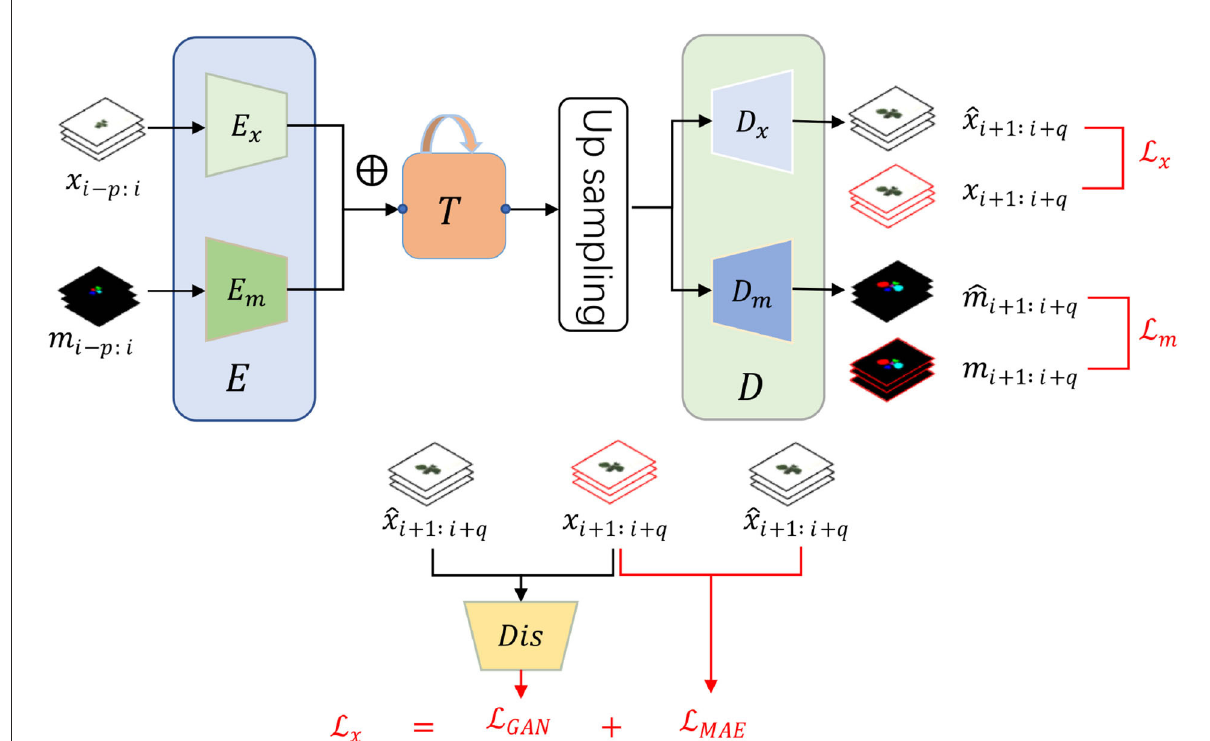
FIGURE1 The framework and loss function of our proposed plant growth prediction model consist of three modules, input encoder E , output decoder D , and an intermediate time-series processing unit T . Encoder and decoder have an individual version of RGB image and instance mask because of the heterogeneity. There are two time-series inputs, historical RGB images x i − p : i and instance masks m i − p : i with two corresponding future predictions, RGB images ˆ x i + 1 : i + q and instance masks ˆ m i + 1 : i + q . ⊕ represents element-wise addition. To train the networks, we design two specific loss functions L x and L m for RGB images and instance masks,